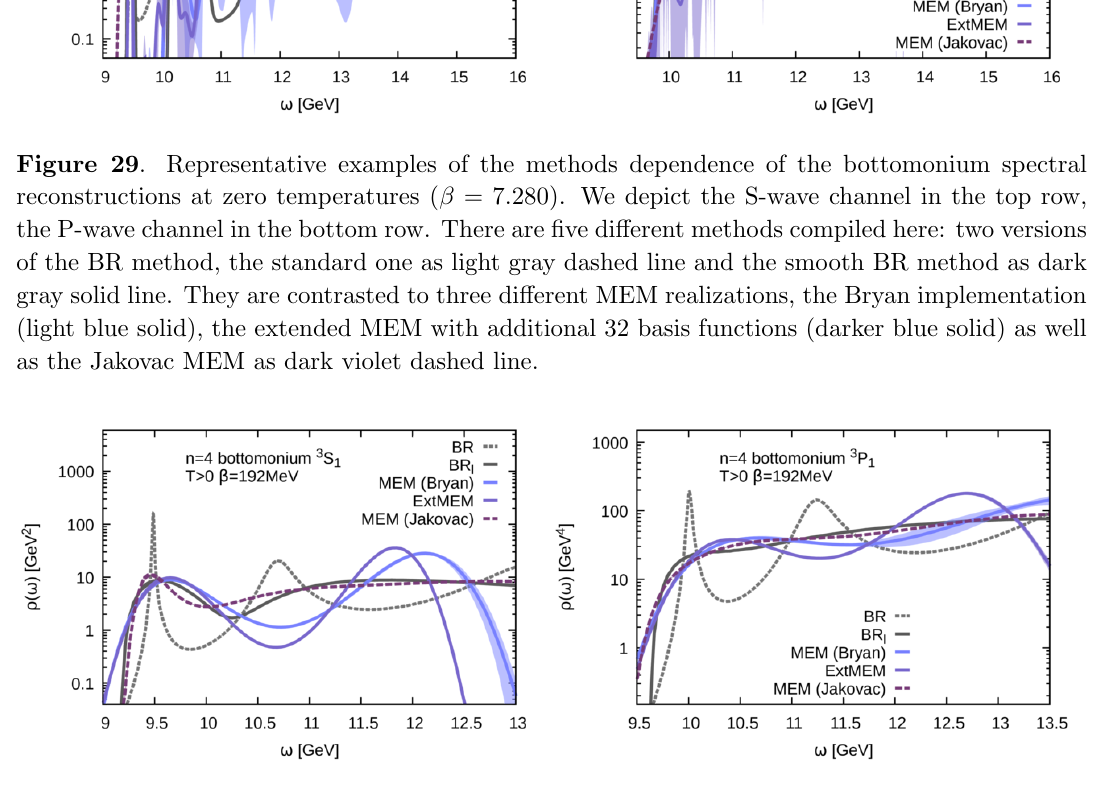
Figure 30 . Representative examples of the methods dependence of the bottomonium spectral reconstructions at T = 192MeV. We depict the S-wave channel in the top panel, the P-wave channel in the bottom panel with the same color and line coding as in the T = 0